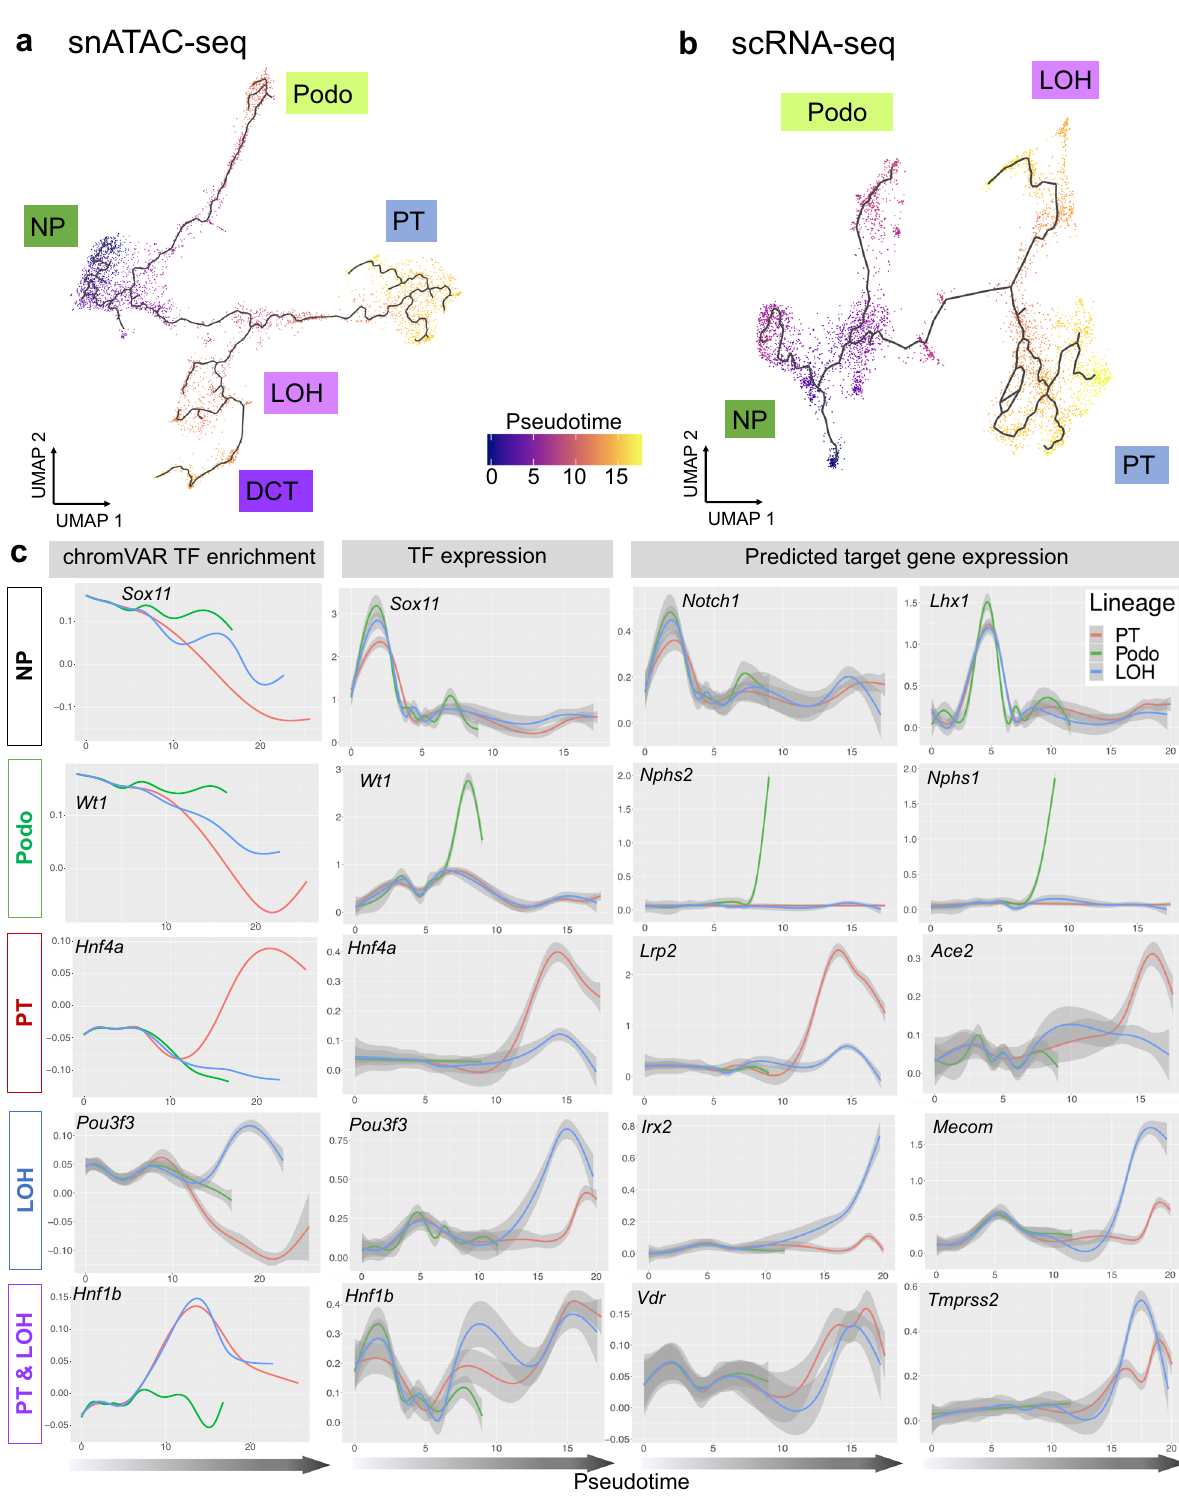
Fig. 3 The cellular trajectory of nephron progenitor differentiation. a UMAP representation of snATAC-seq nephron progenitor differentiation trajectory towards podocytes, proximal tubule, loop of Henle and distal convoluted tubule, respectively, as inferred by Cicero. Cells are colored by pseudotime. b UMAP representation of scRNA-seq nephron progenitor differentiation trajectory towards podocytes, proximal tubule and loop of Henle, respectively, as inferred by Monocle3. Cells are colored by pseudotime. c Pseudotime-dependent chromatin accessibility and gene expression changes along the proximal tubule (red), podocyte (green), and loop of Henle (blue) cell lineages. The fi rst column shows the dynamics of chromVAR TF enrichment score, the second column shows the dynamics of TF gene expression values and the third and fourth column represent the dynamics of SCENIC-reported target gene expression values of corresponding TFs, respectively. Error bars denote 95% con fi dence intervals of local polynomial regression fi tting. Additional examples are given in Supplementary Fig.